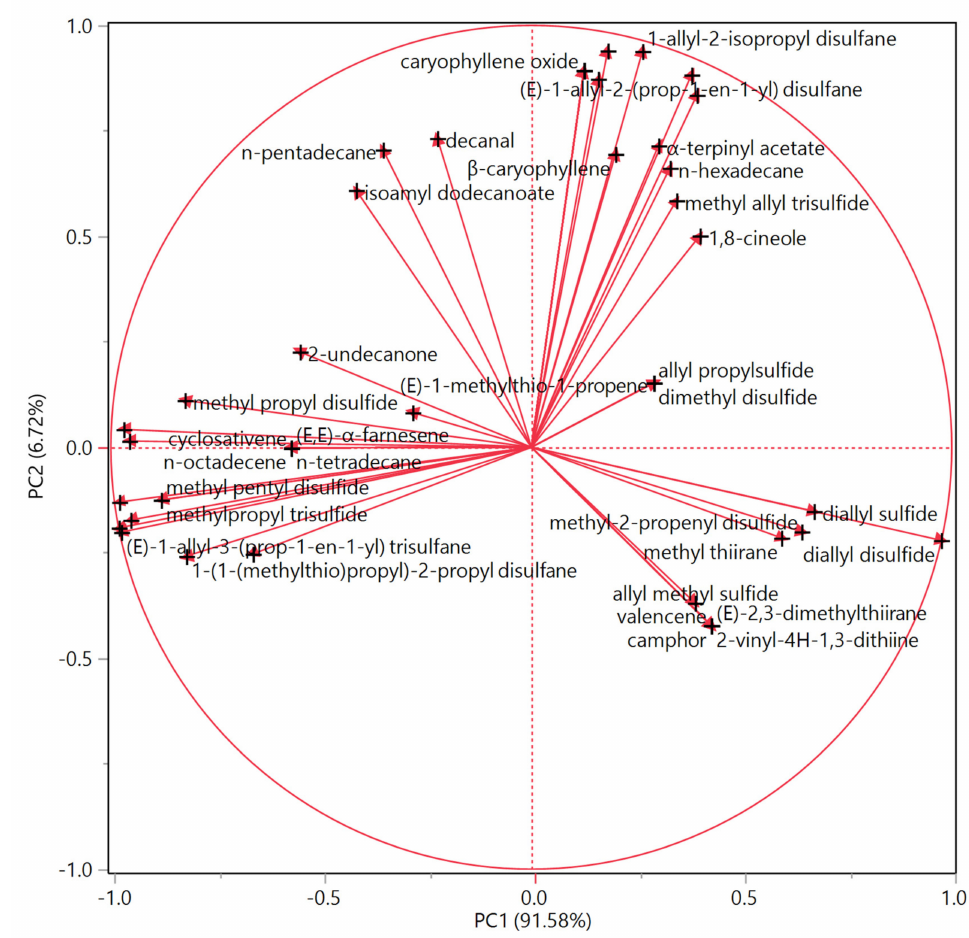
Figure 3. Loadings plot of the principal component analysis (PCA) performed on the complete compositions of both whole and cut samples of elephant garlic ( Allium ampeloprasum var. holmense (Mill.) Asch. et Graebn), garlic ( A. sativum L.), and leek ( A. ampeloprasum